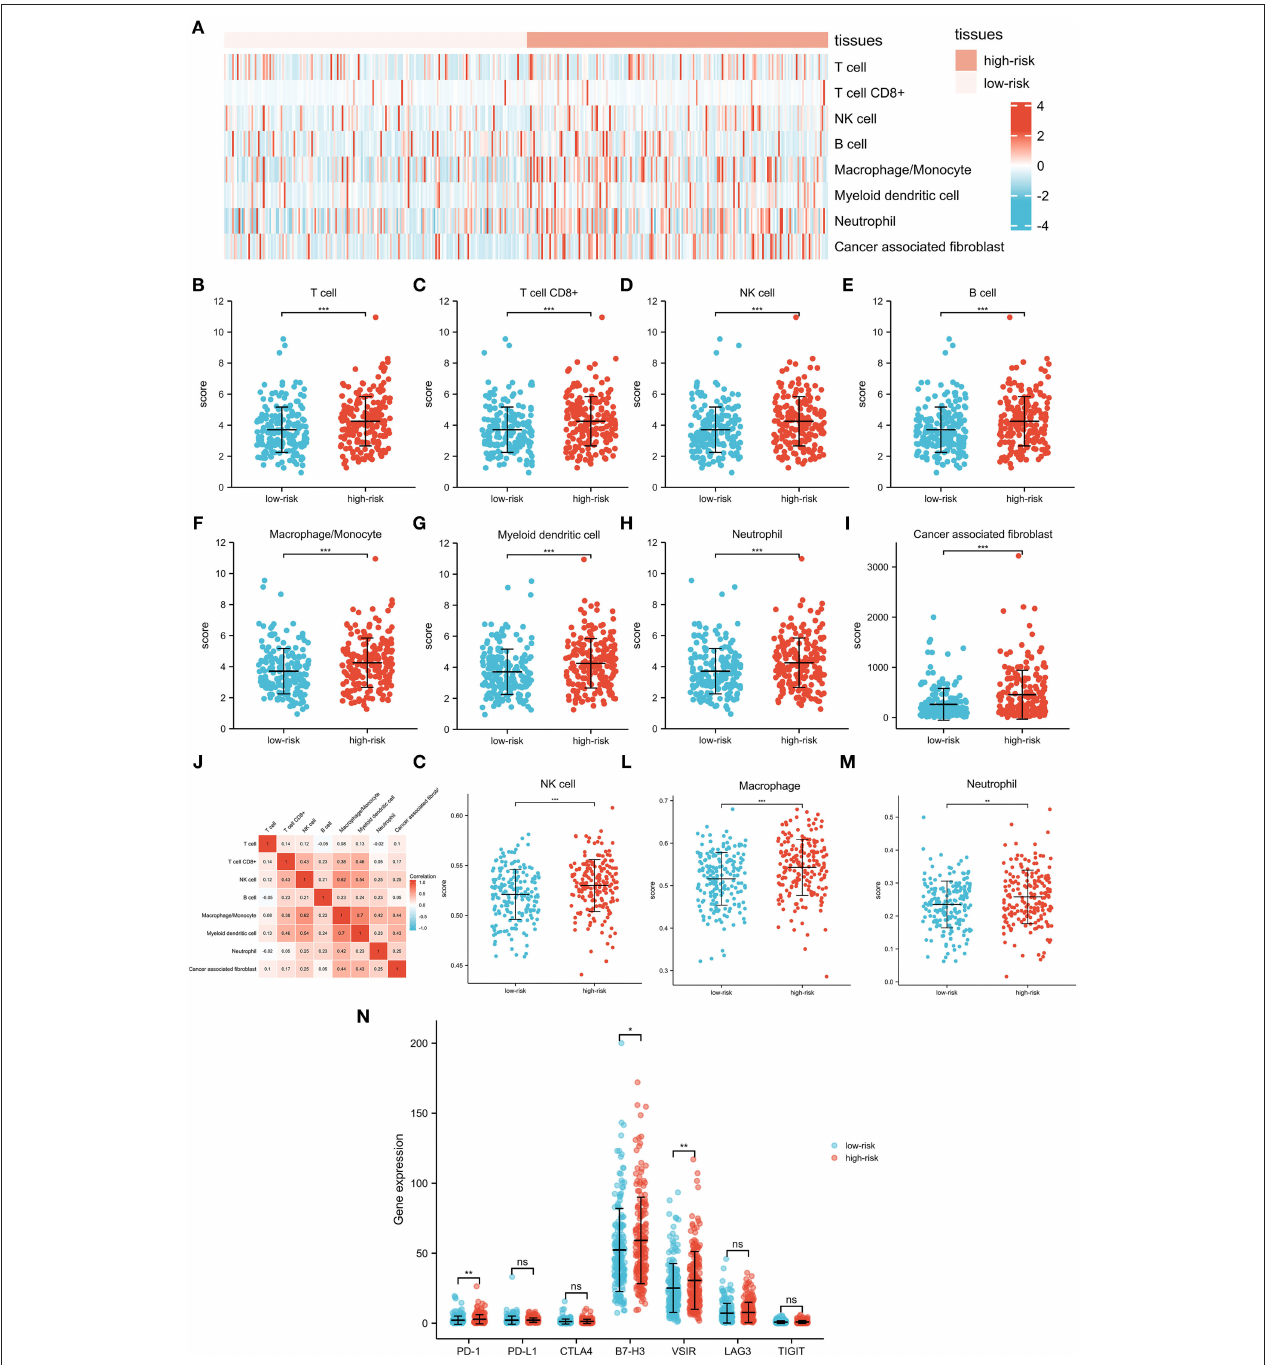
FIGURE 6 | Interactions between the pyroptosis-related lncRNA signature and immune regulation in patients with OC. (A) Heatmap of the tumor-infiltrating cell in low-risk and high-risk patients. (B) Comparisons of T cell between the low-risk group and the high-risk group. (C) Comparisons of CD8T cell between the low-risk group and the high-risk group. (D) Comparisons of NK cell between the low-risk group and the high-risk group. (E) Comparisons of B cell between the low-risk group and the high-risk group. (F) Comparisons of macrophage/monocyte between the low-risk group and the high-risk group. (G) Comparisons of myeloid dendritic cell between the low-risk group and the high-risk group. (H) Comparisons of neutrophil between the low-risk group and the high-risk group. (I) Comparisons of cancer-associated fibroblast between the low-risk group and the high-risk group. (J) Correlation matrix of immune cells in OC. (K) Comparisons of NK cell between the low-risk group and the high-risk group using the ssGSEA algorithm. (L) Comparisons of macrophage between the low-risk group and the high-risk group using the ssGSEA algorithm. (M) Comparisons of neutrophil between the low-risk group and the high-risk group using the ssGSEA algorithm. (N) Comparisons of multiple immune checkpoints between the low-risk group and the high-risk group, including PD-1, PD-L1, CTLA4, B7-H3, VSIR, LAG3, and TIGIT.